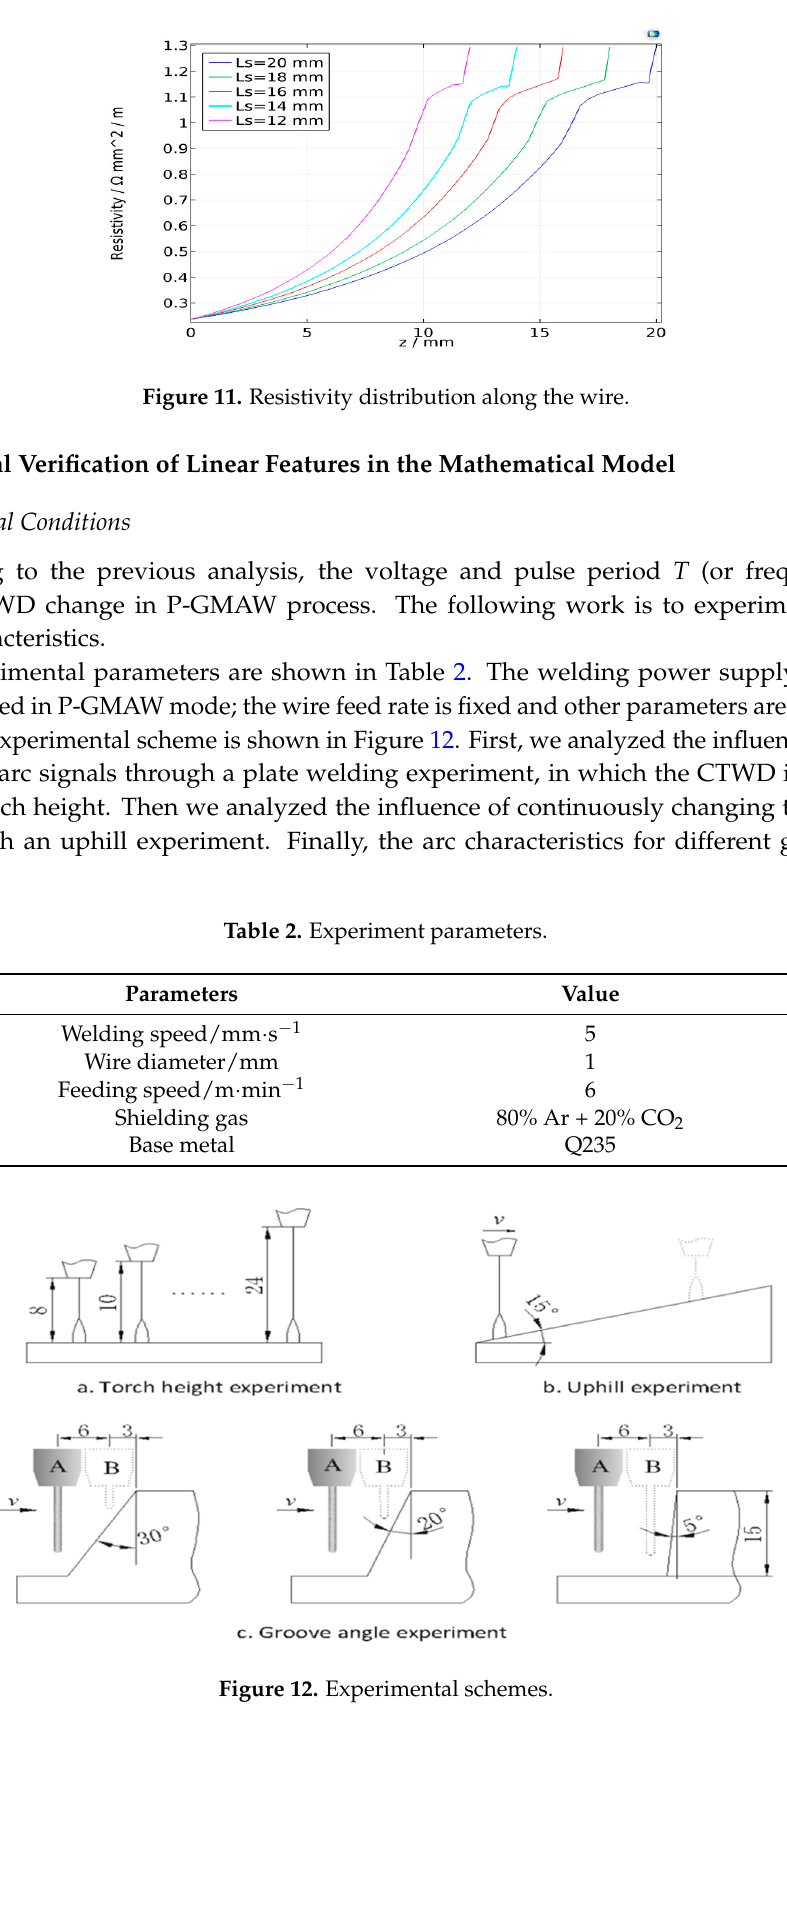
Figure 10. Temperature distribution along the wire.